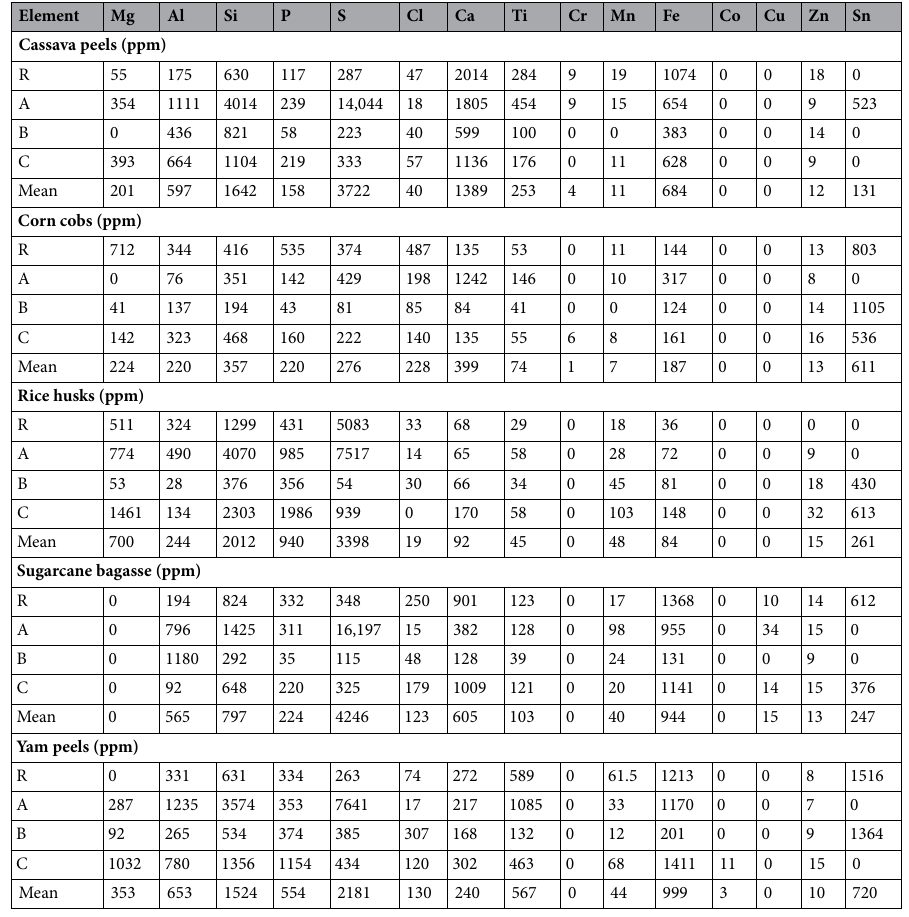
Table 1. Effect of acid, alkaline, and hydrothermal pretreatment on the raw biomass samples. R = Raw. A = Acid pretreated. B = Alkaline Pretreated. C = Hydrothermal Pretreated.